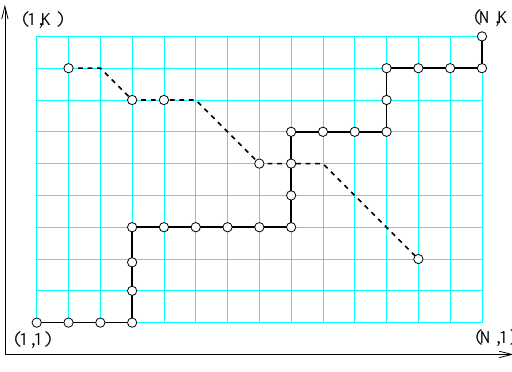
Fig. 5: A path from P (plain line) and a path from (cid:0) P (dashed